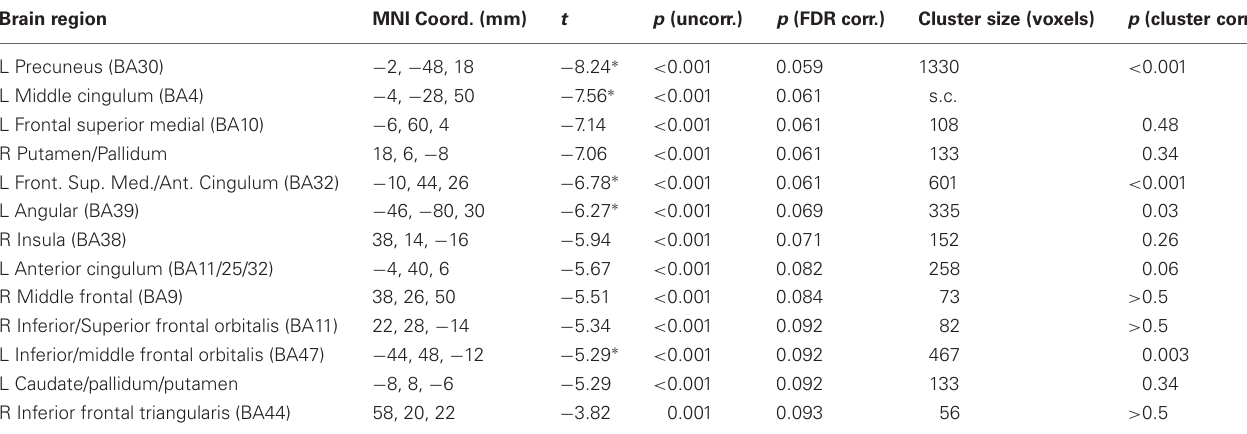
Table 6 | Regression of emotional contrast on individual scores in use of emotional words in recounting the stories in writing. Brain region